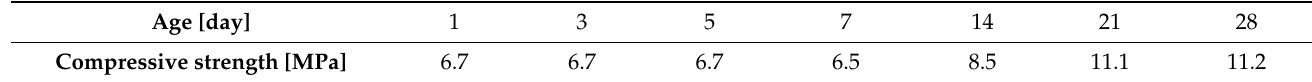
Table 6. Compressive strength tests results.